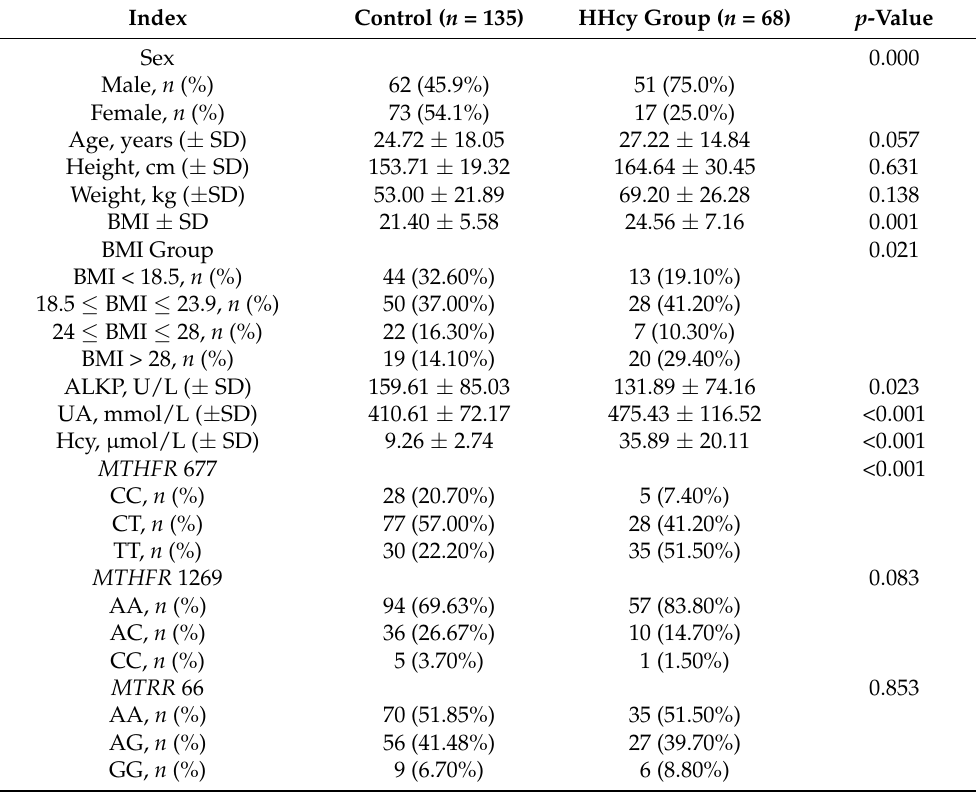
Table 1. Characteristics of the control and HHcy group